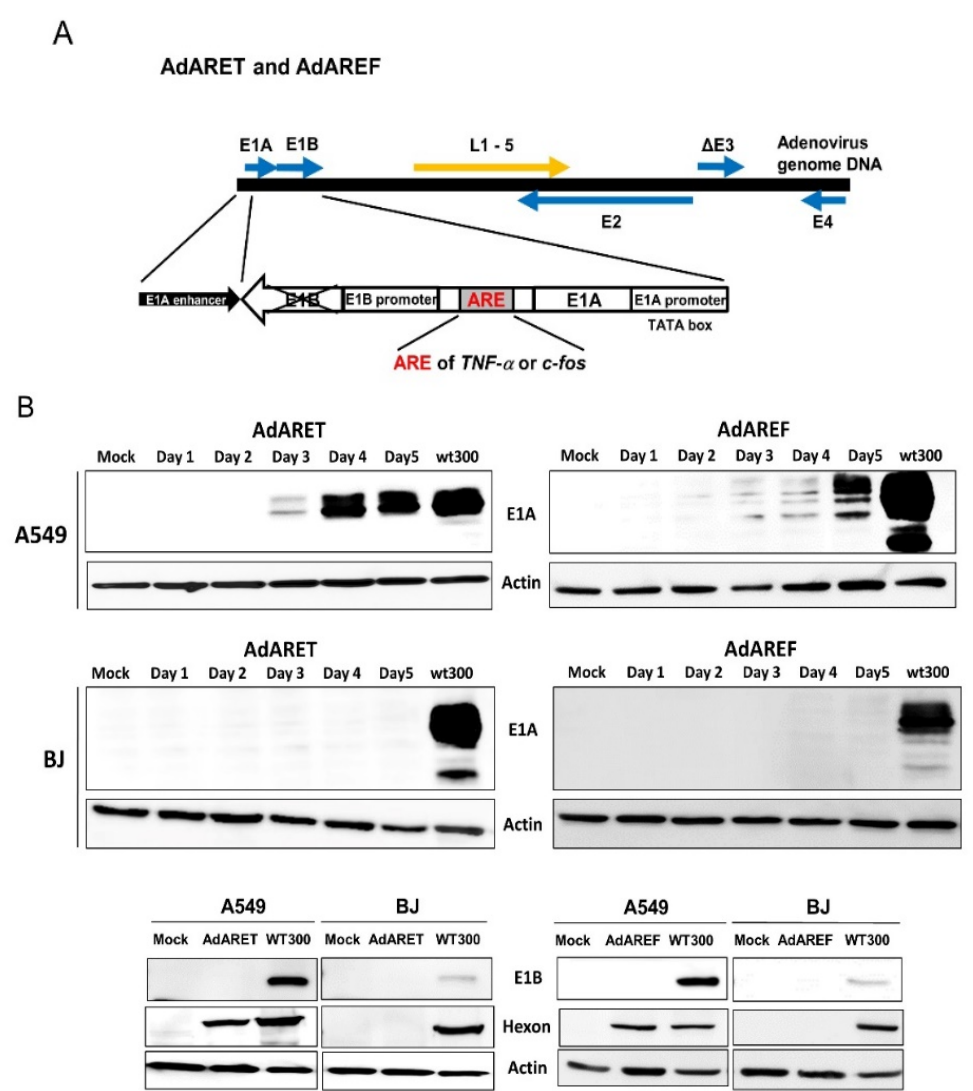
Figure 1. Structure of AU-rich element (ARE)-containing oncolytic adenoviruses and the expression of virus gene products. ( A ) Schematic representation of AdARET and AdAREF with the ARE of the TNF- α and c-fos genes in the 3 (cid:48) -UTR of the E1A gene, respectively. The location and direction of the inserted E1 region including ARE is indicated by a white arrow. Early (E1–4) and late (L1–5) genes are indicated by arrows. TATA box in E1A promoter is marked. ( B ) E1A expression in both new viruses (AdARET and AdAREF at a Multiplicity of Infection (MOI) 100 vp / cell day 1 to 5) and wild-type adenovirus (WT300 at an MOI 10 vp / cell, 24 h of infection) infected A549 and BJ cells were detected by western blot analysis. (upper and middle) E1B55k and hexon protein expression in the cells infected with the same viruses. (bottom) WT300 infected cells were used as a positive control, while non / mock infection was used as a negative control. β -actin expression was used as a loading control. The uncropped blots and molecular weight markers are shown in Figure